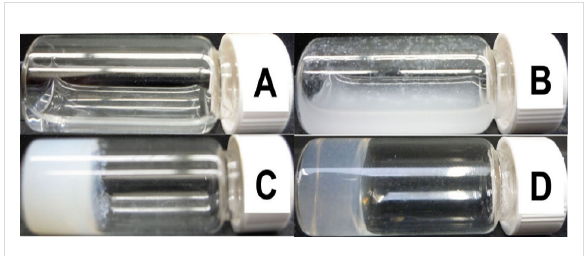
Figure 2: The optical images of (A) solution of 6 (2 wt %, pH = 9.0), (B) suspension of 6 (2 wt %, pH = 6.5), (C) opaque gel of 6 (2 wt %, pH = 4.6), (D) transparent gel of 6 (2 wt %, pH = 4.6, aging for 10